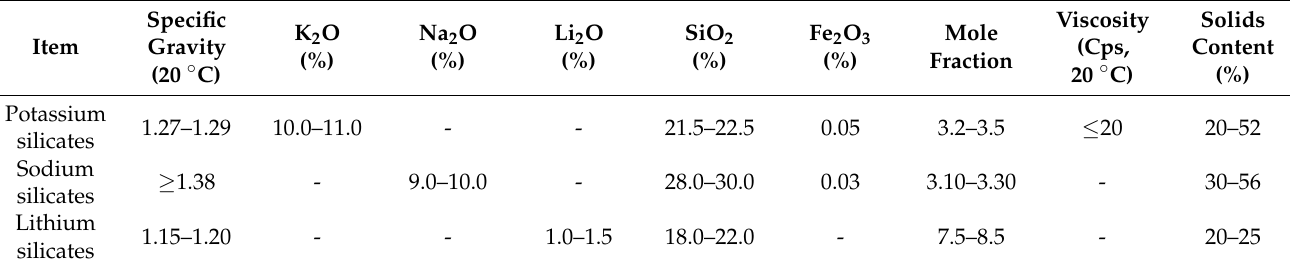
Table 1. Physical properties and chemical components of each